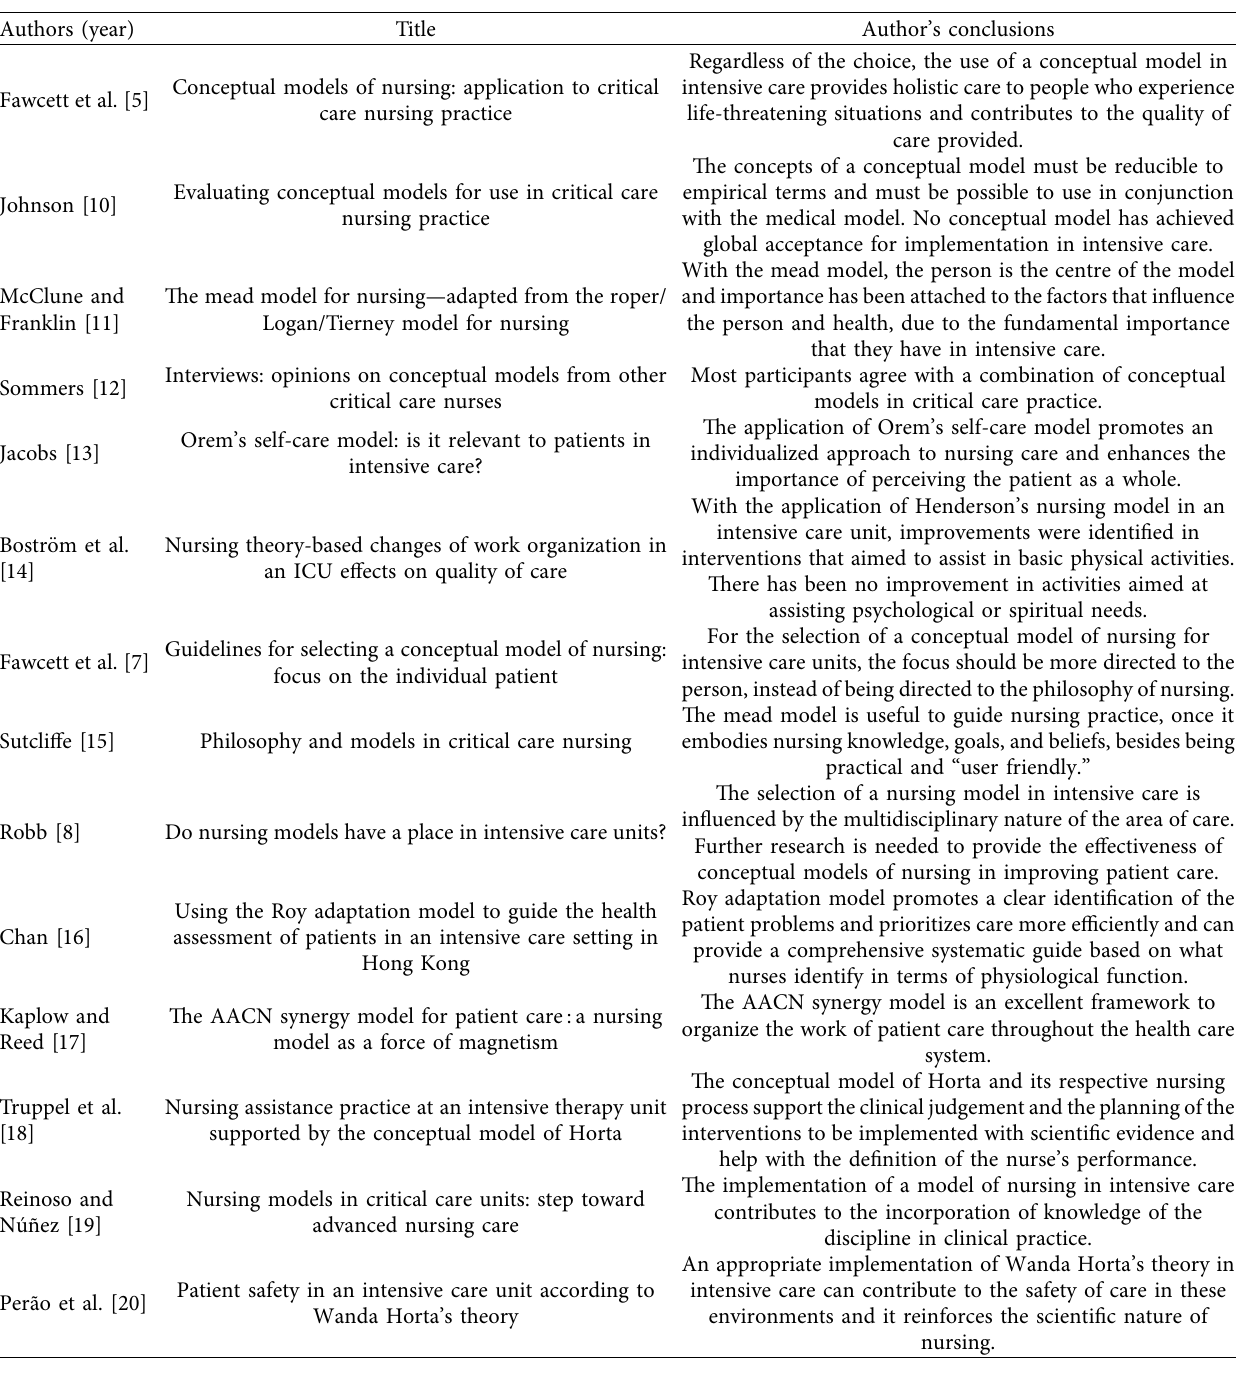
Table 1: Synopsis of the analyzed